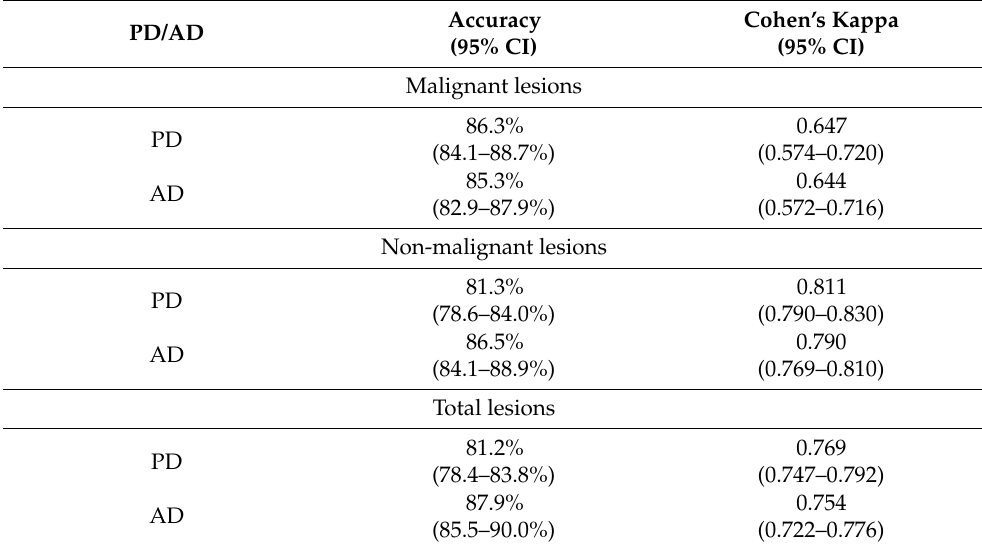
Table 3. Overall diagnostic